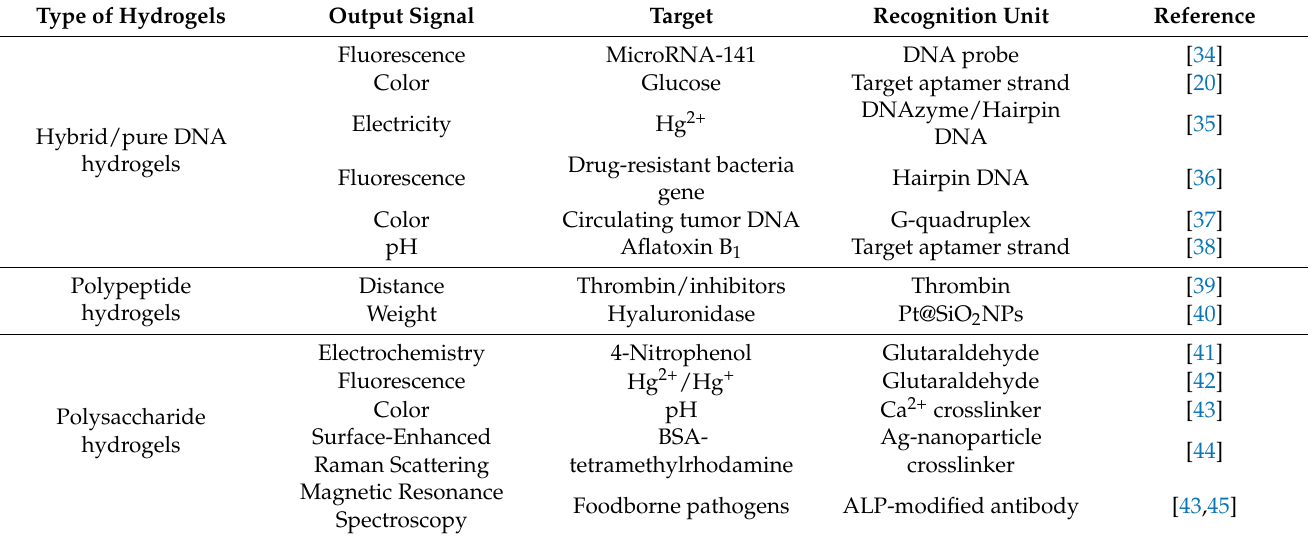
Table 1. Examples of hydrogels with different recognition units.